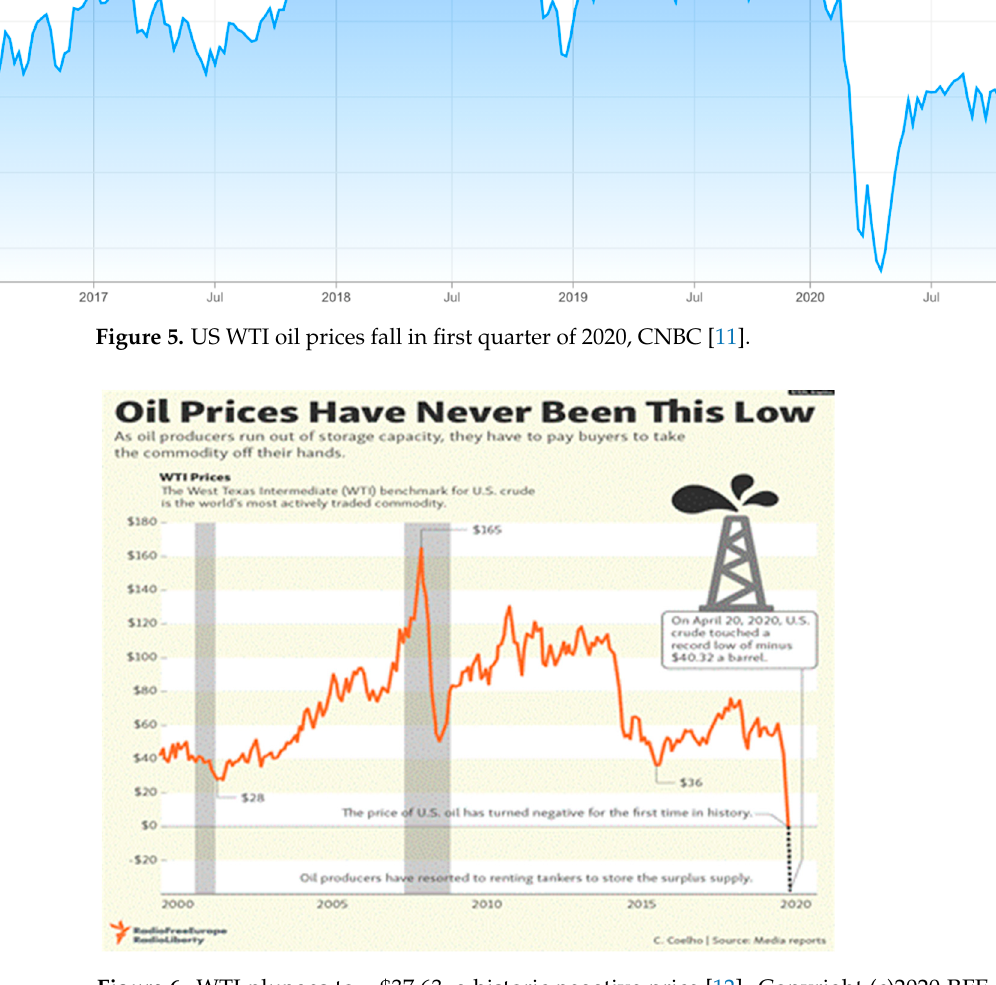
Reprinted with the permission of Radio Free Europe/Radio Liberty, 1201 Connecticut Ave NW, Ste 400, Washington DC